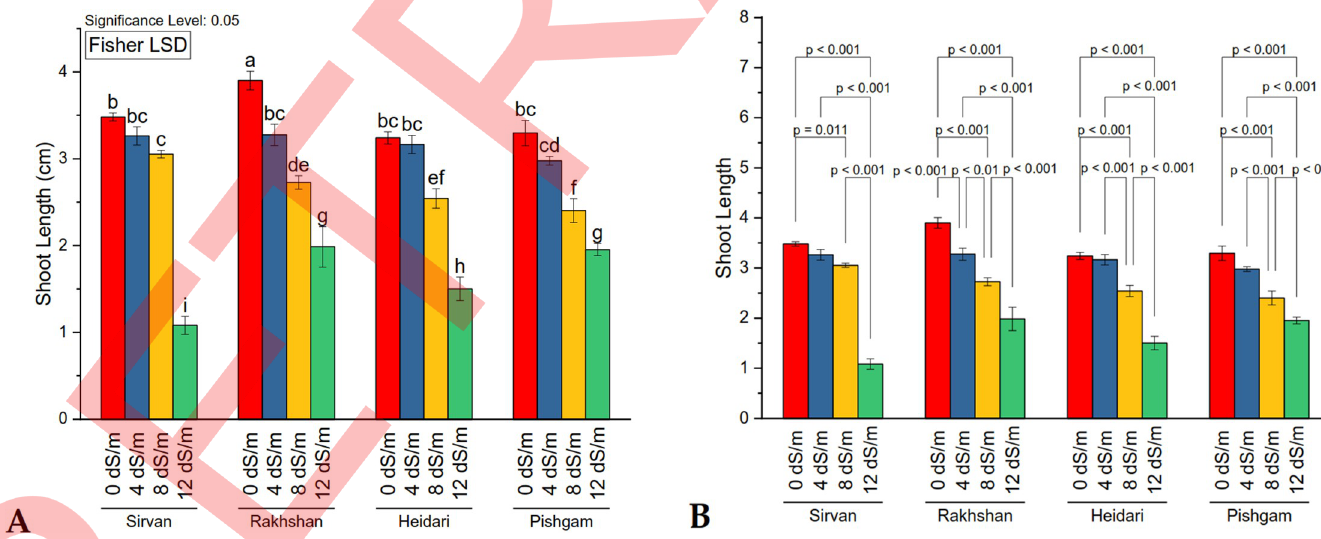
Fig 4. Effects of salinity on shoot length in wheat varieties. A) Means are average of four replicates. Different values showed significant difference at p < 0.05 compared by LSD. B) Different values at bars are p values obtained during LSD comparison of wheat varieties and salinity levels.